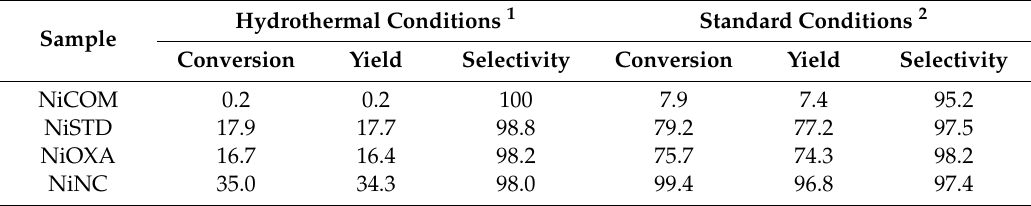
Figure 6. Catalytic results of the levulinic acid transformation into γ -valerolactone on different Ni catalysts: ( A ) Yield to γ -valerolactone, ( B ) productivity to γ -valerolactone per mass of catalyst ( ■ ) or per surface area ( ● ). Notes: Reaction temperature = 180 °C, reaction time = 2 h, 62.5 mg of catalyst and remaining reaction conditions in the Materials and Method section. Productivity per mass of catalyst expressed as mol GVL Kg cat − 1 h − 1 . Productivity per area of catalyst expressed as 10 − 4 mol GVL m − 2 h − 1 .